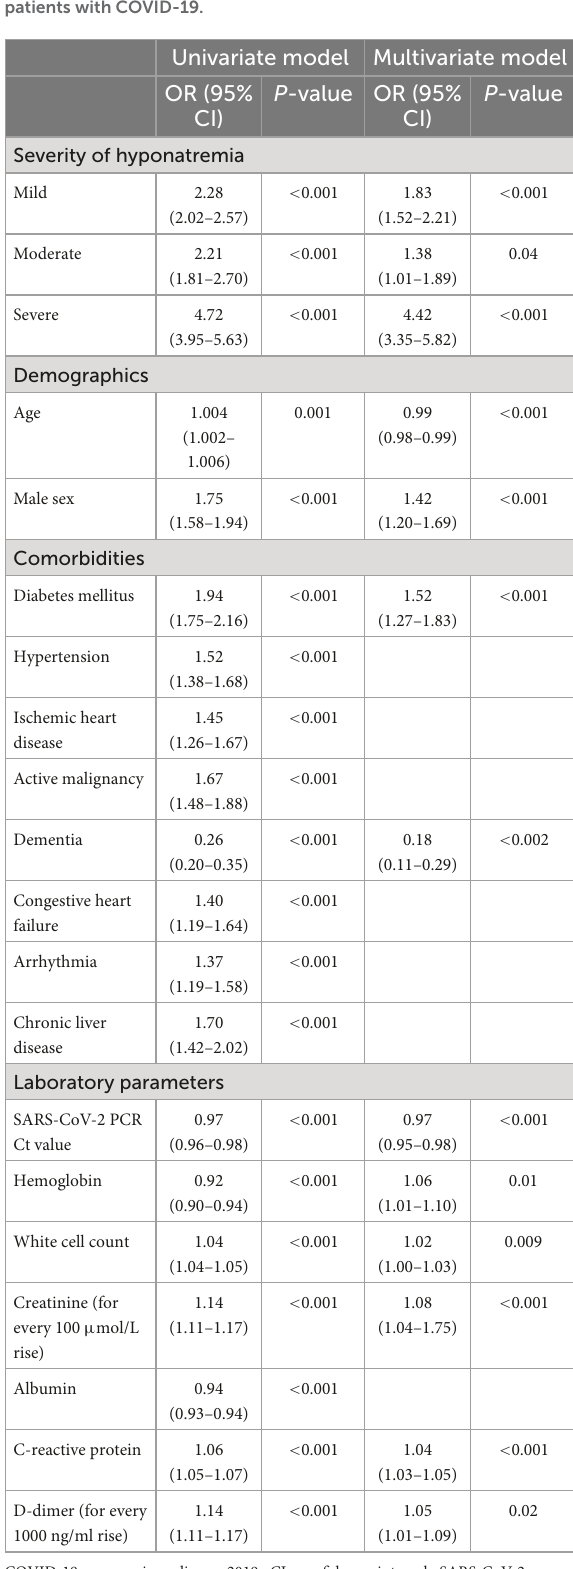
TABLE 4 Risk factors for 30-day mortality in patients with